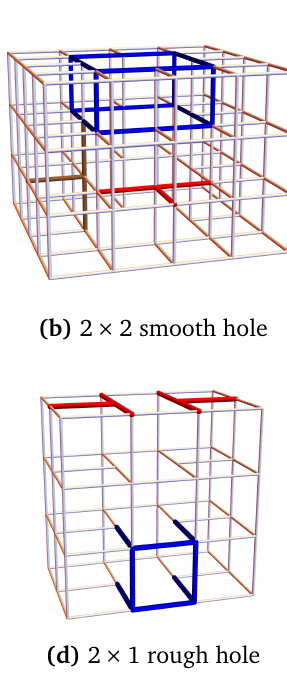
Figure 21: The X-cube model with holes. The shapes of the nontrivial cube (blue) and vertex (red and brown) terms are highlighted. We note that the Hamiltonian terms at edge of the holes resemble the terms at the smooth and rough outer boundaries. For each type of hole, there is also a cube or vertex term that surrounds the entire hole. Note that in (d), there is just a single disconnected vertex term that is the product of six operators on the six red links.